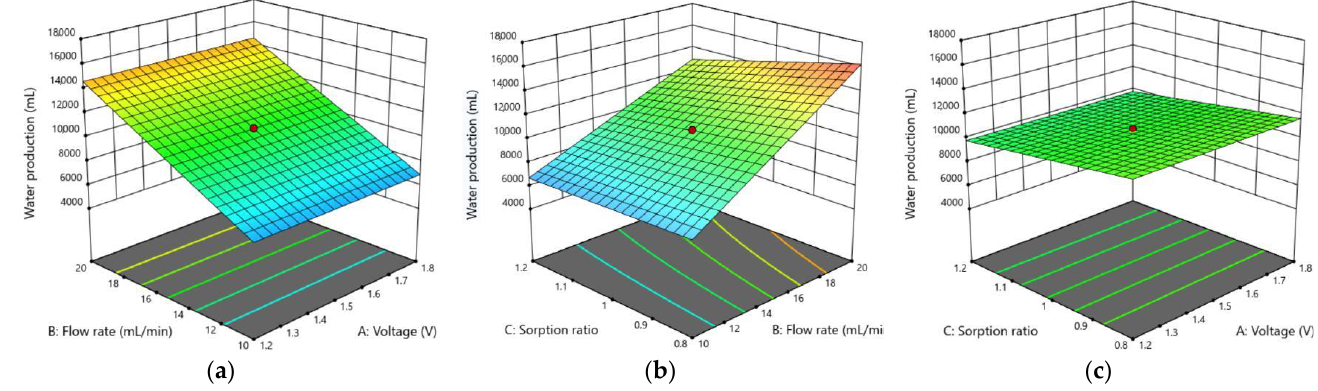
Figure 8. 3D response surface plots showing the effects of the three main factors on water produc- tion using the CDI: ( a ) voltage and flow rate; ( b ) flow rate and sorption ratio; ( c ) voltage and sorption